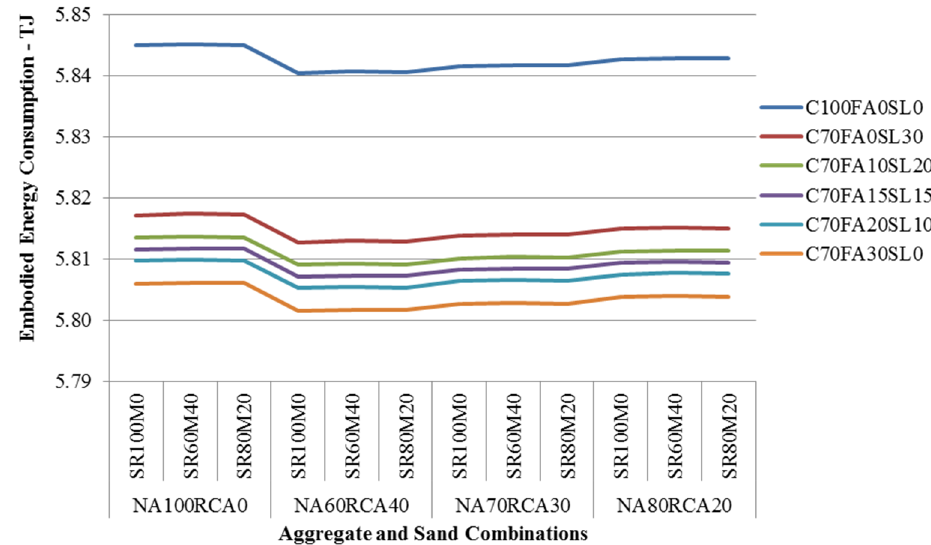
Figure 6. Embodied Energy consumption of CCSWH using by ‐ products for concrete.